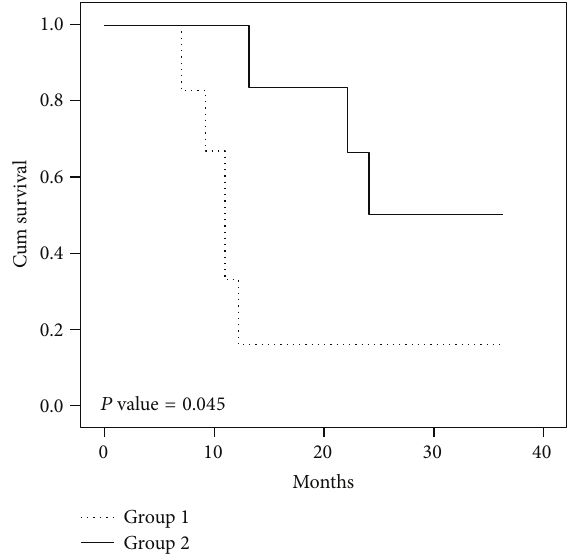
Figure 7: Kaplan-Meier analysis revealed that the 3-year survival was 50% in group 1 versus 16.7% in group